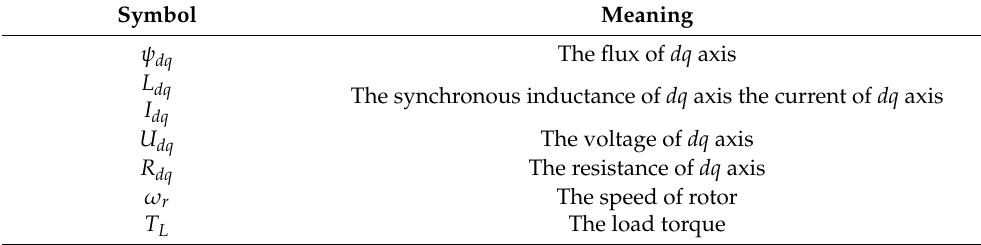
Table 2. Symbols Table 2. Symbols list.